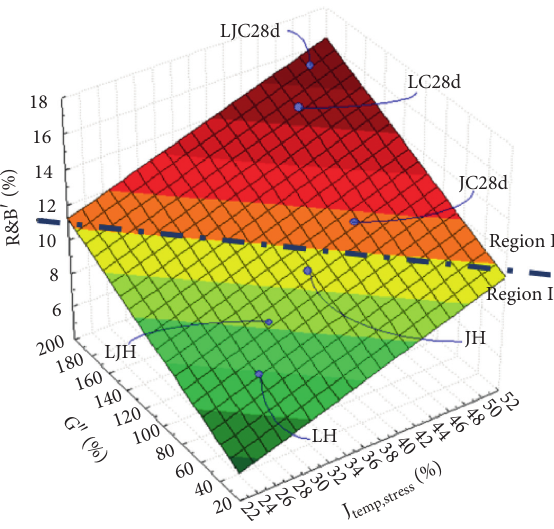
Figure 15: R&B ′ against J